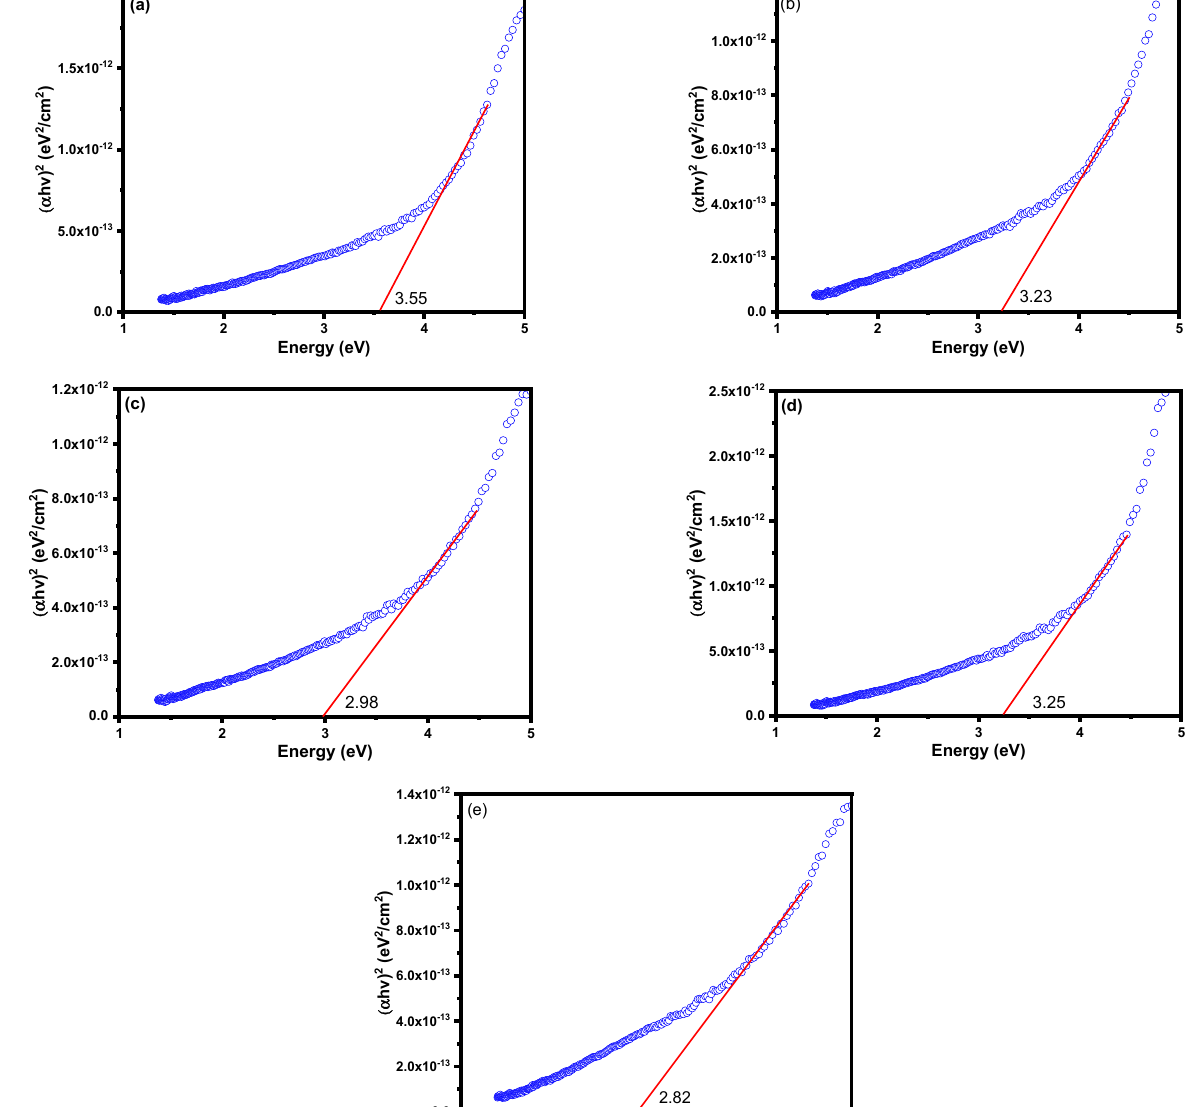
Figure 7. The Tauc plots for ( a ) LaMnO 3, ( b ) LaMnO 3 -Ag, ( c ) LaMnO 3 -Au, ( d ) LaMnO 3 -Pd, and ( e ) LaMnO 3 -Pt samples.